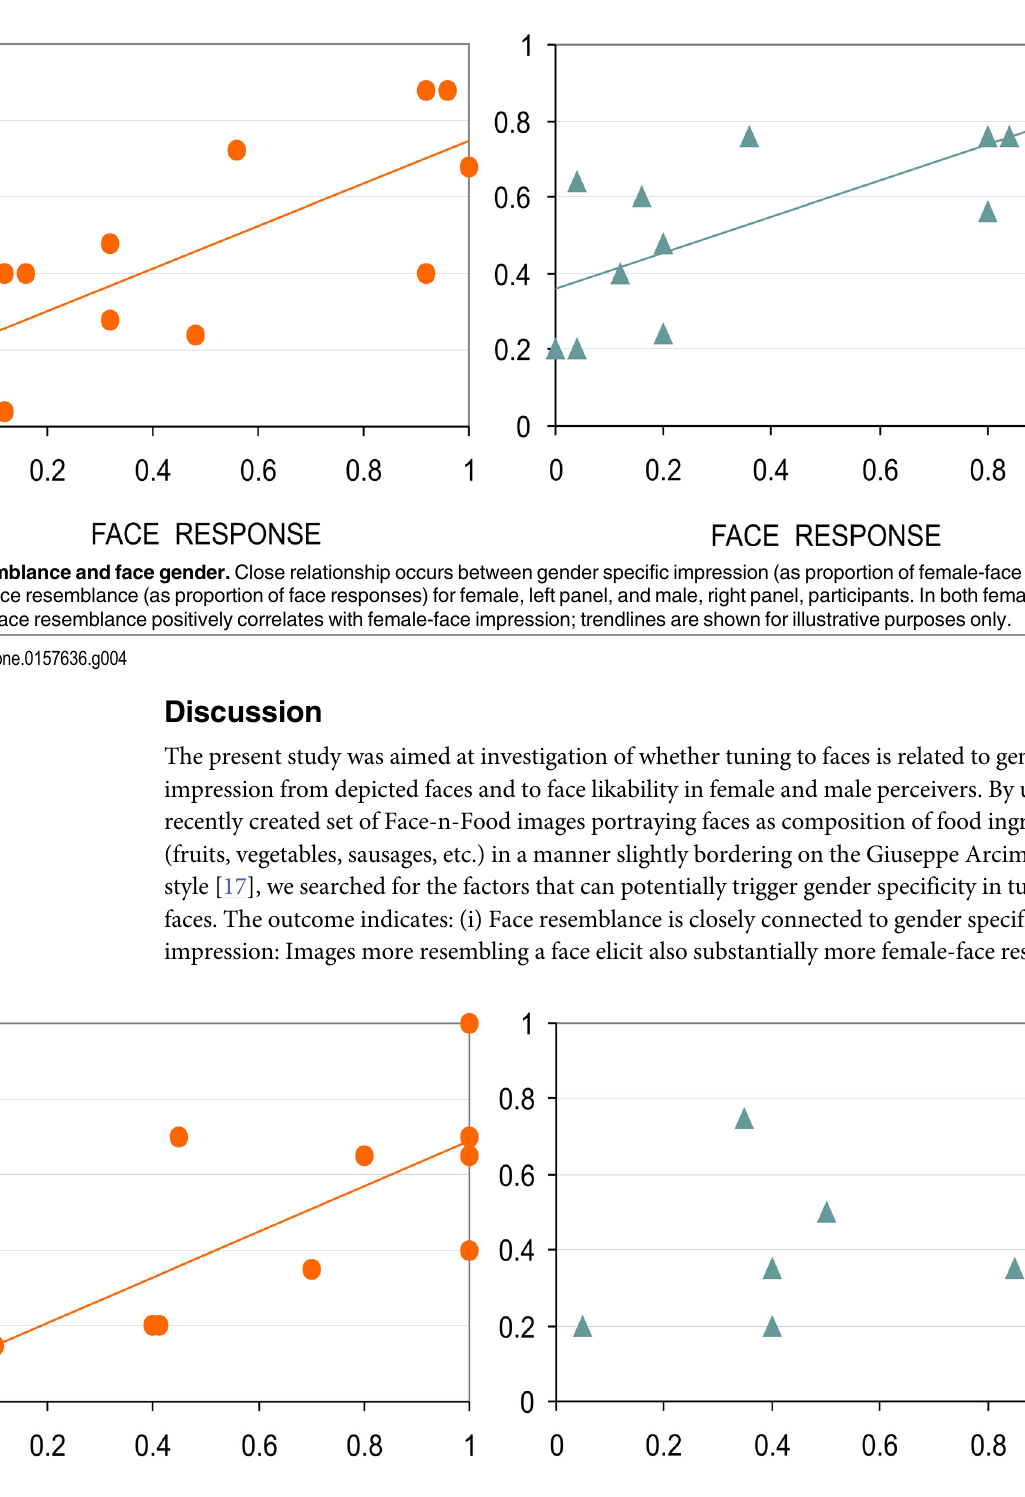
PLOS ONE | DOI:10.1371/journal.pone.0157636 June 28,